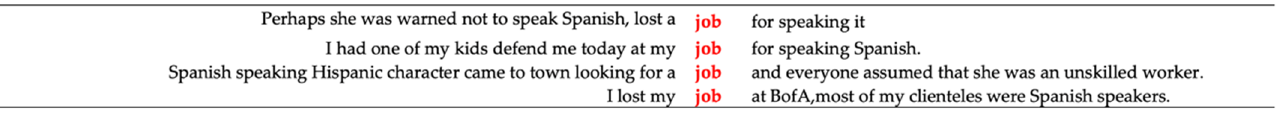
Figure 2. Concordance lines for job that indicate positive attitudes on the status dimension.